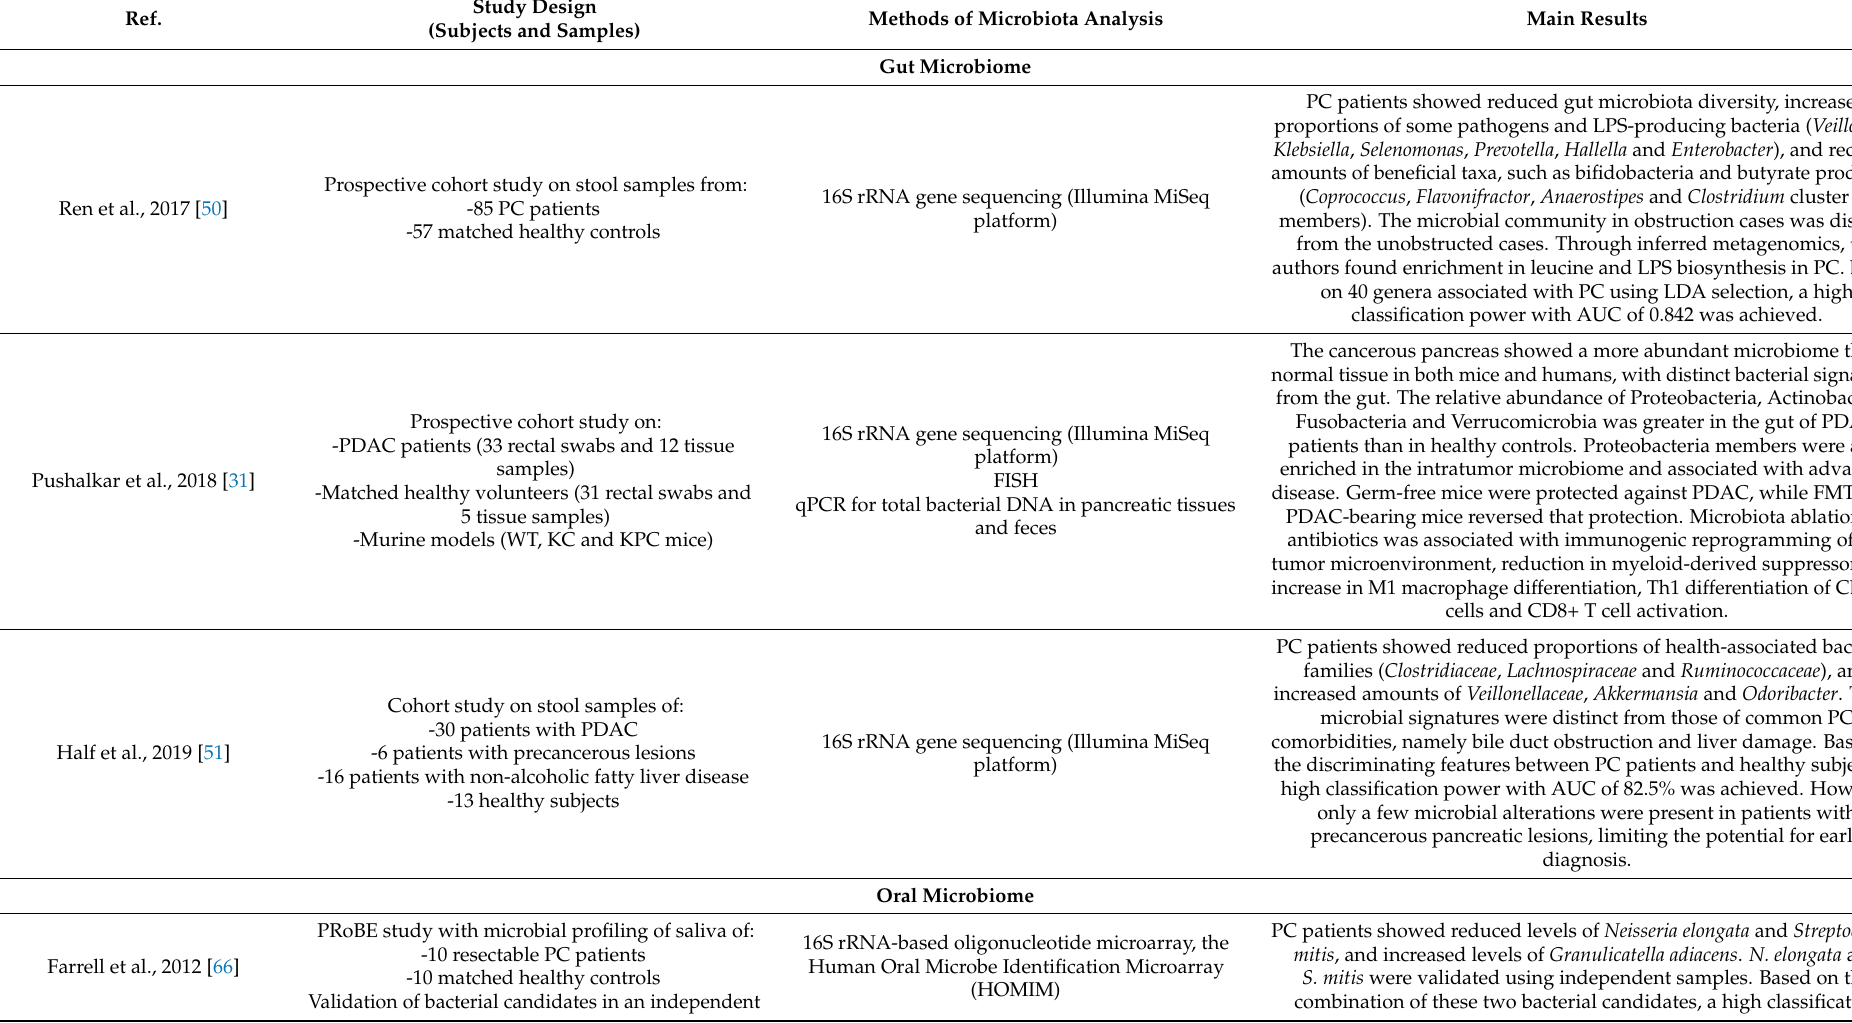
Table 1. List of relevant studies on alterations in host-associated microbiomes and pancreatic cancer. For each study, the design, the method of microbiota analysis, the main results and the reference are reported. The following microbiomes were considered: gut, oral and intra-tumoral.